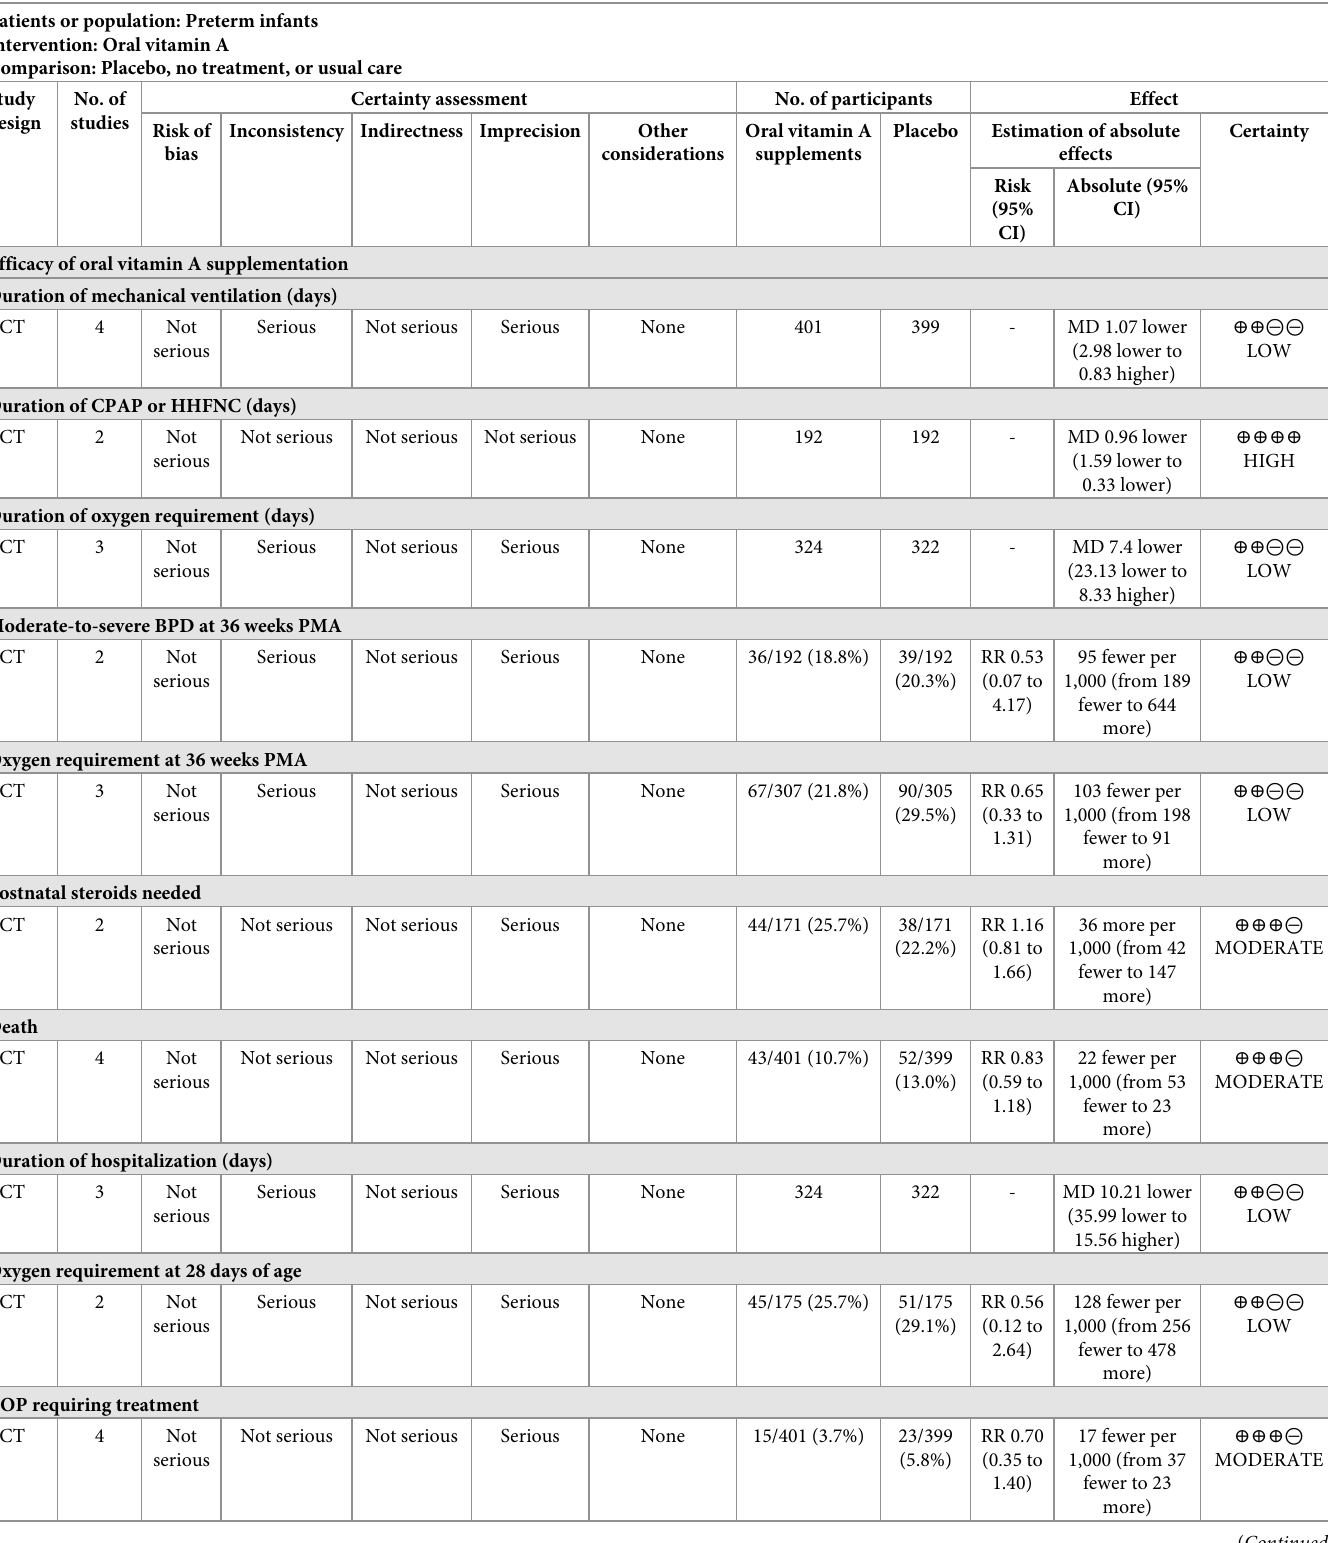
Table 2. GRADE summary of findings: Effects of oral vitamin A supplementation on clinical outcomes in preterm infants. Patients or population: Preterm infants Intervention: Oral vitamin A Comparison: Placebo, no treatment, or usual